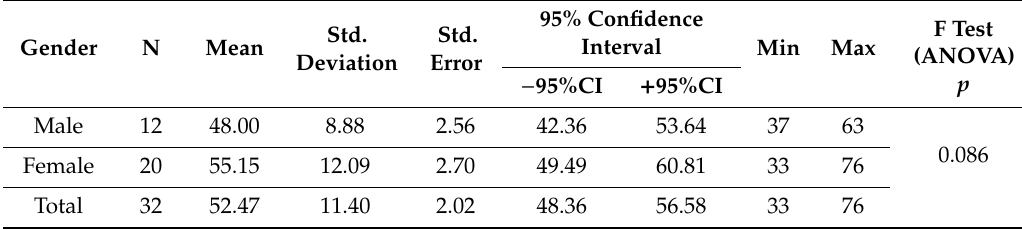
Table 8. Descriptive statistics of the overall score by gender.